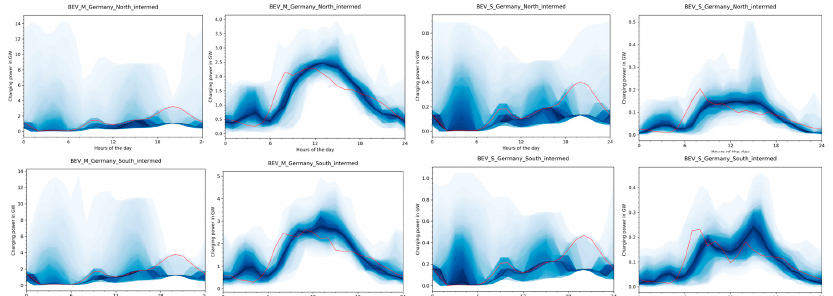
Figure A7. Daily probability distributions for total charging (controlled and uncontrolled) of medium and small sized BEV fleets in Northern Germany ( top row ) and Southern Germany ( bottom row ) in winter hours (1440–3600 and 5760–7920). The first and the third column show S1 results and the second and third column show S2 results. A case of completely uncontrolled charging is shown as red line.